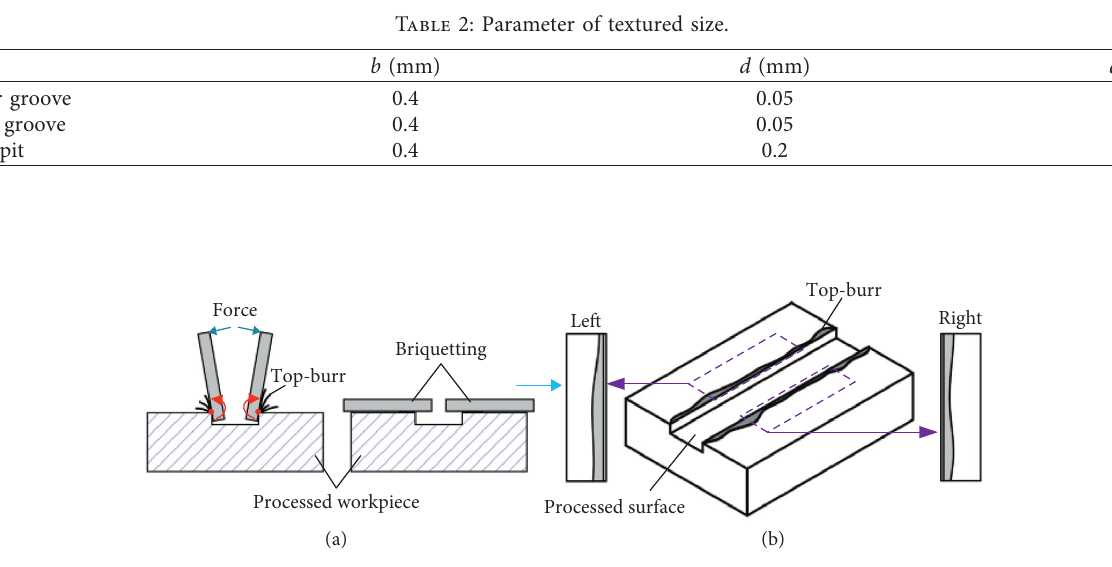
Figure 2: Schematic diagram of the measuring method of top-burr. (a) Top-burr flattening diagram; (b) schematic diagram of the sampling